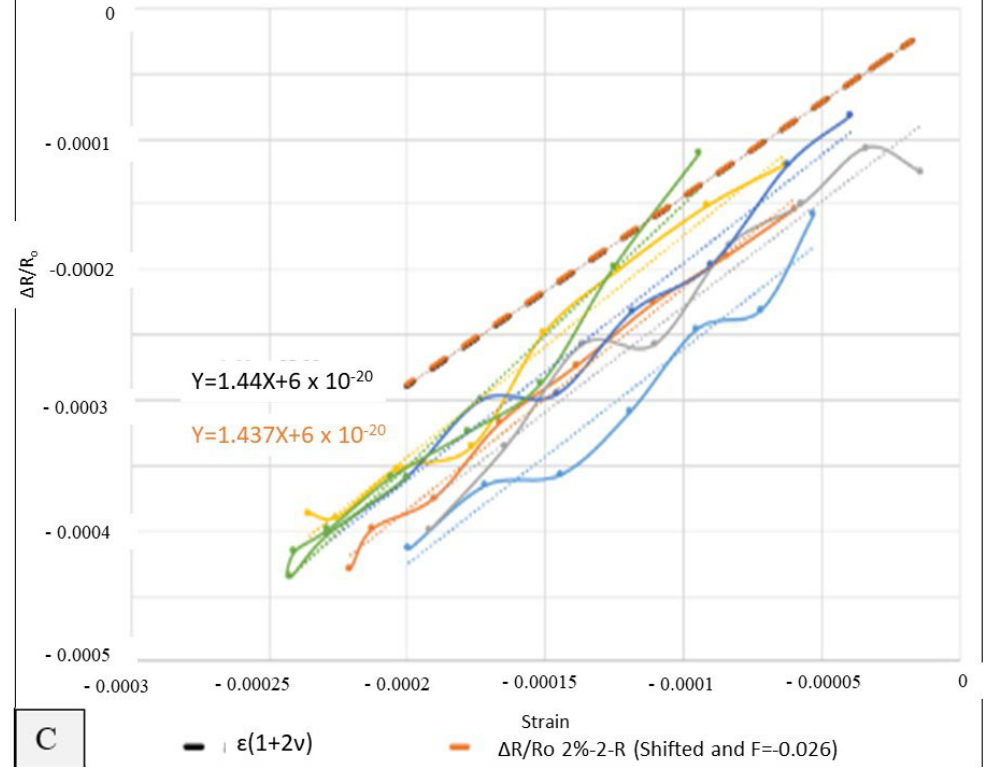
Figure 10. Elasto-Electric Parameter X–Y Scatter Plot with Mechanical vs. Electrical Measurements for Load Test 2 for (( A ) Left Electrode, ( B ) Middle Electrode, and ( C ) Right Electrode). A best fit value is determined for each load test and for each electrode set.